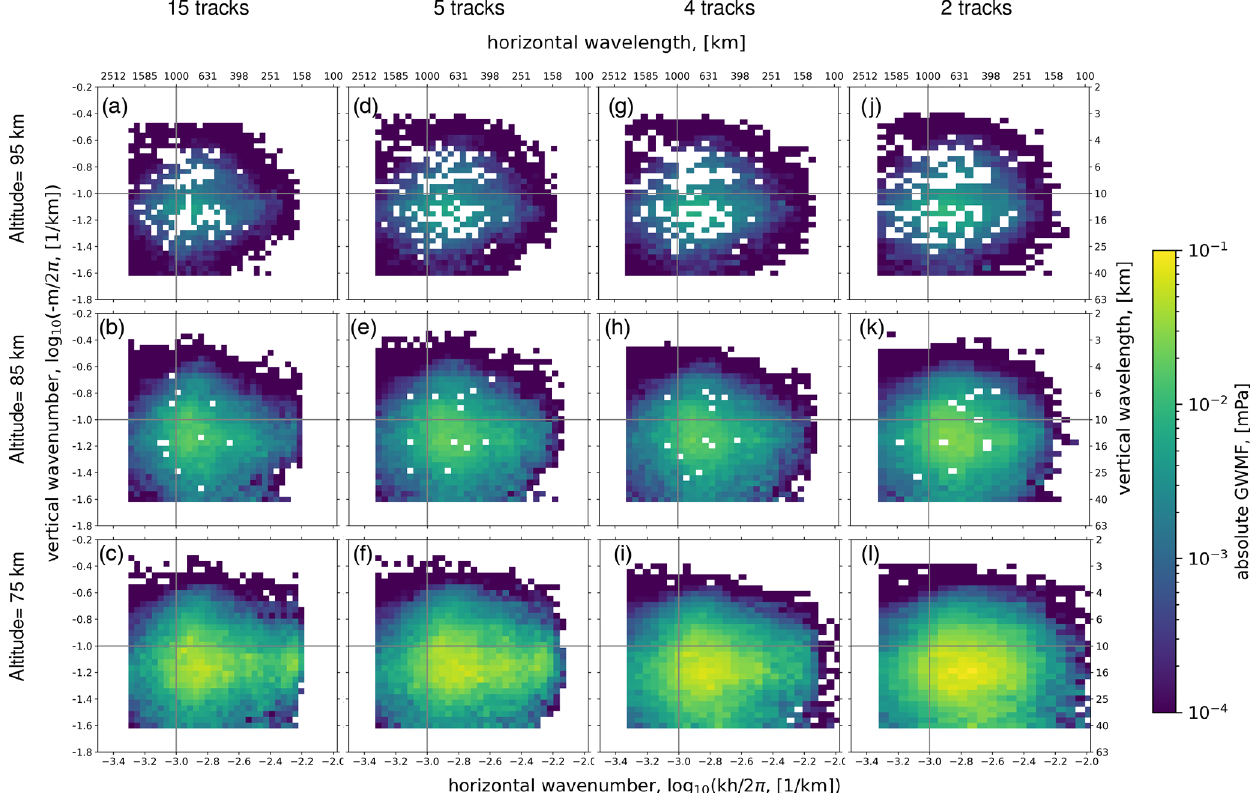
Figure 10. Distribution spectra of GW pseudomomentum flux versus logarithmic horizontal and vertical wavenumbers at 75km (bottom panels), 85km (middle panels), and 95km (upper panels) altitude. Varying cube sizes in the across-track direction of 15 tracks (a–c) , 5 tracks (d–f) , 4 tracks (g–i) , and 2 tracks (j–l) are applied. The 15- and 5-track analyses are for sampled data, while 4- and 2-track analyses are for retrieval data with realistic noise. Flagged-out data due to insufficient fitting quality result in more blank bins for 95km altitude. The gray reference lines through the plots indicate 1000km horizontal and 10km vertical wavelength,